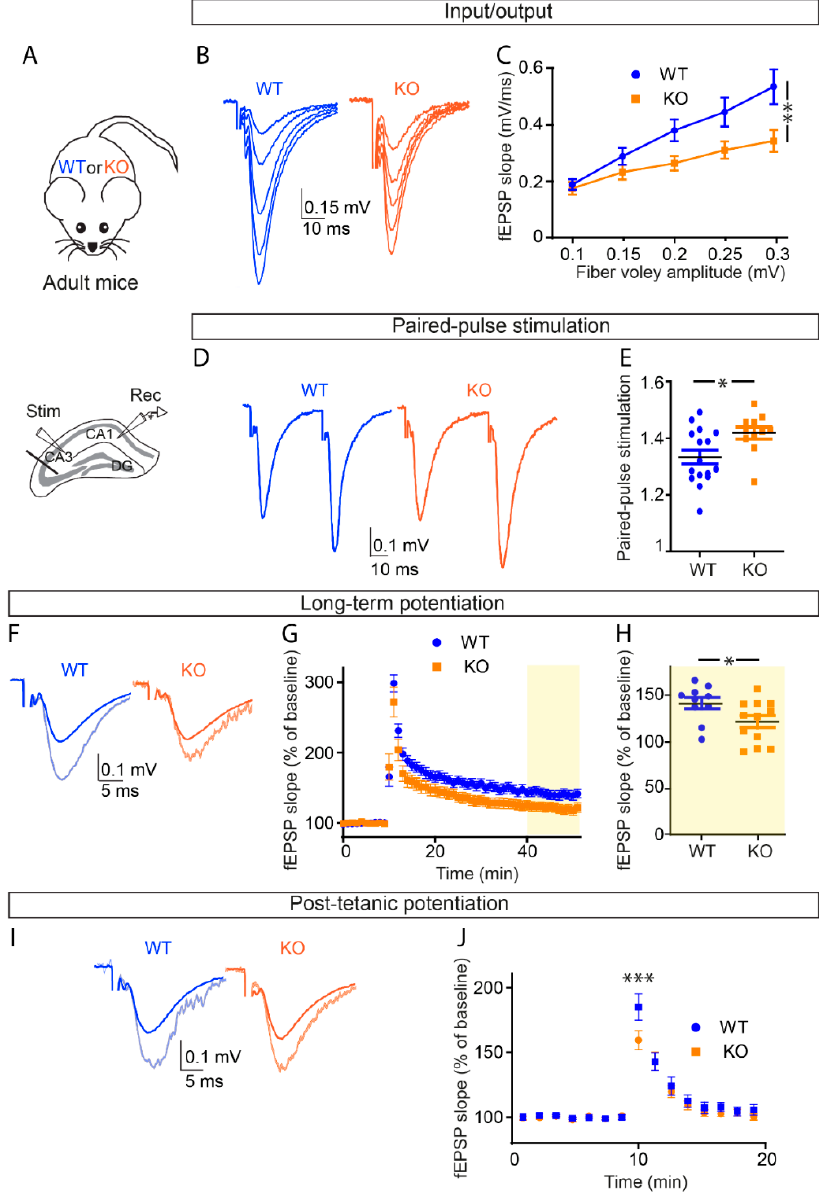
Figure 2. Basal excitatory synaptic transmission is reduced in adult OPHN1-deficient mice. ( A ) Scheme of the hippocampus illustrating the arrangement of the stimulating electrode, to activate the Schaffer collaterals, and of the neuronal recording electrode (extracellular), to record fEPSPs evoked by the stimulation in the CA1 area of KO mice or WT littermates. ( B , C ) The input/output curve shows that basal excitatory synaptic transmission is reduced KO mice ( n = 7 slices from five mice) as compared to WT littermates ( n = 7 slices from five mice) (two-way ANOVA, interaction (genotype × fiber volley amplitude, p < 0.0001; Bonferroni post hoc test at 0.3 mV, p = 0.0022). ( D , E ) Paired-pulse facilitation (PPF) is increased in KO adult mice ( n = 11 slices from five mice) as com- pared to WT littermates ( n = 16 slices from five mice), suggesting a reduction in the release proba- bility (unpaired t -test, p = 0.0194; DF = 25). ( F – H ) Long-term potentiation (LTP) was measured by field potential recordings (fEPSPs) at CA1 Schaffer collateral synapses in KO mice as compared to